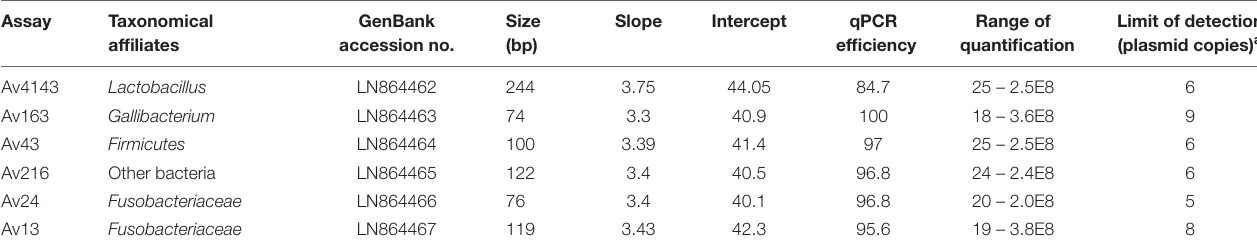
TABLE 2 | Performance features of qPCR assays.